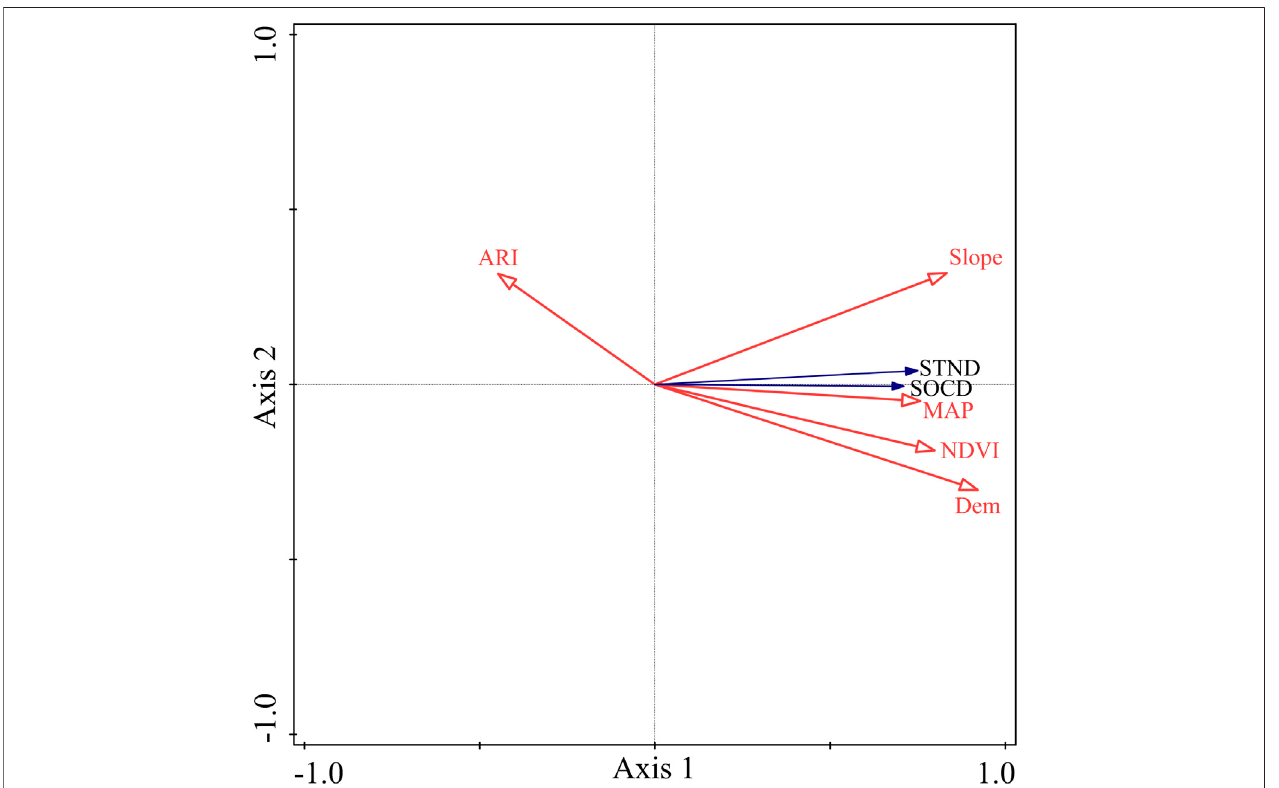
FIGURE 6 | Redundancy analysis ordination diagram for soil organic carbon density ( SOCD ) and soil total nitrogen density ( STND ) to a depth of 100 cm and the associated in fl uence factors. Abbreviations: ARI , the aridity index (evaporation/precipitation); CAT , cumulative annual temperature; DEM , elevation; MAT , mean annual temperature, NDVI , the normalized-difference vegetation index; MAP , mean annual precipitation; TMI , Thornthwaite ’ s moisture index.